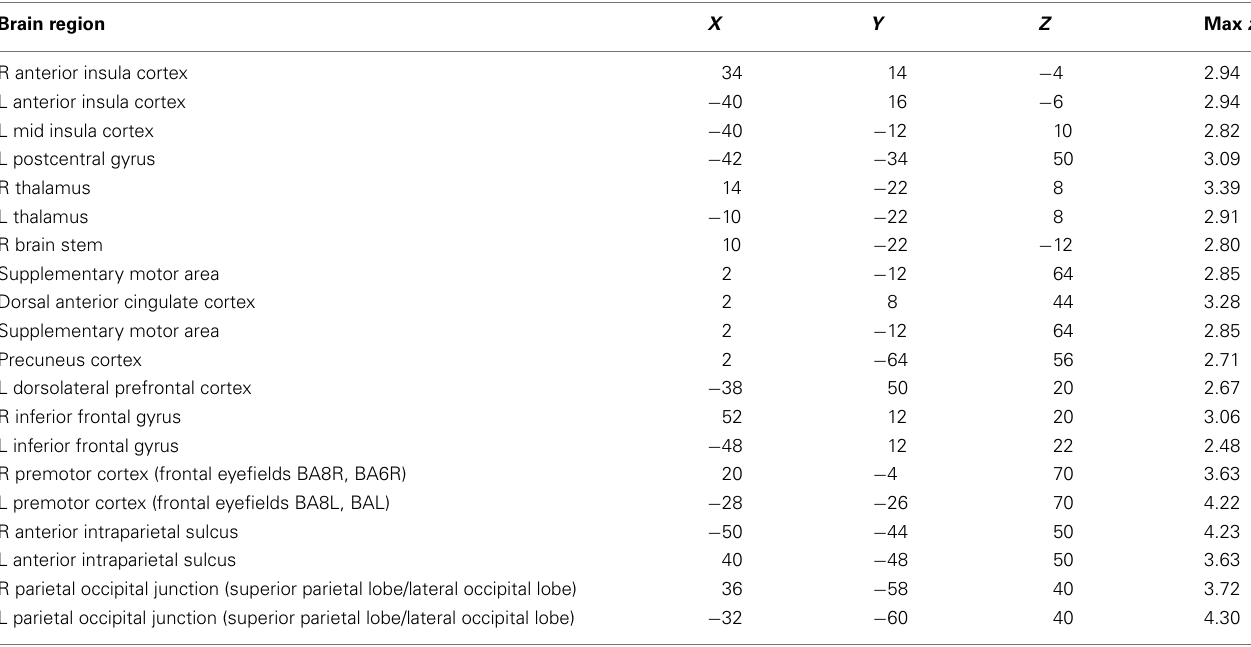
TableA2 | Complete list of brain regions showing significant BOLD activation during target detection as a function of parametrically increasing interval length. during odd 3 as compared to odd 1.